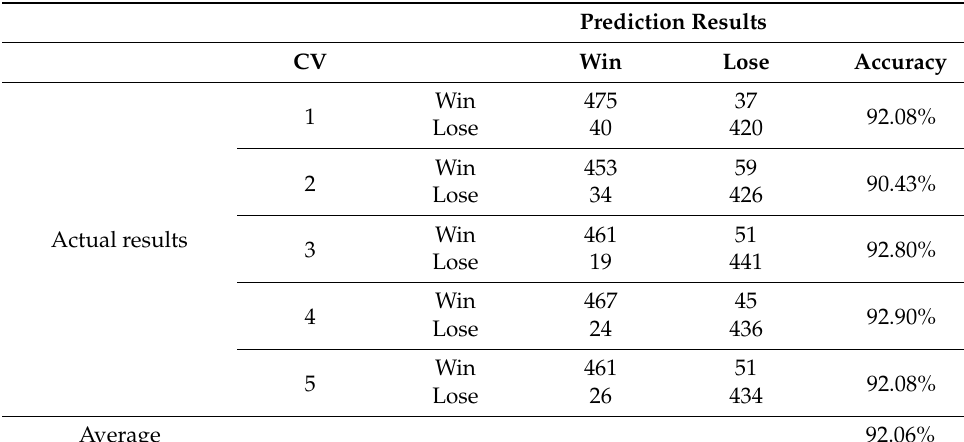
Table 9. Confusion matrix of ANN after feature selection (dataset 1).